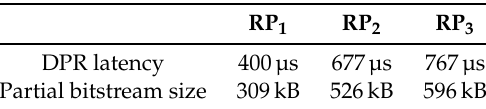
Table 7. DPR latency (worst-case